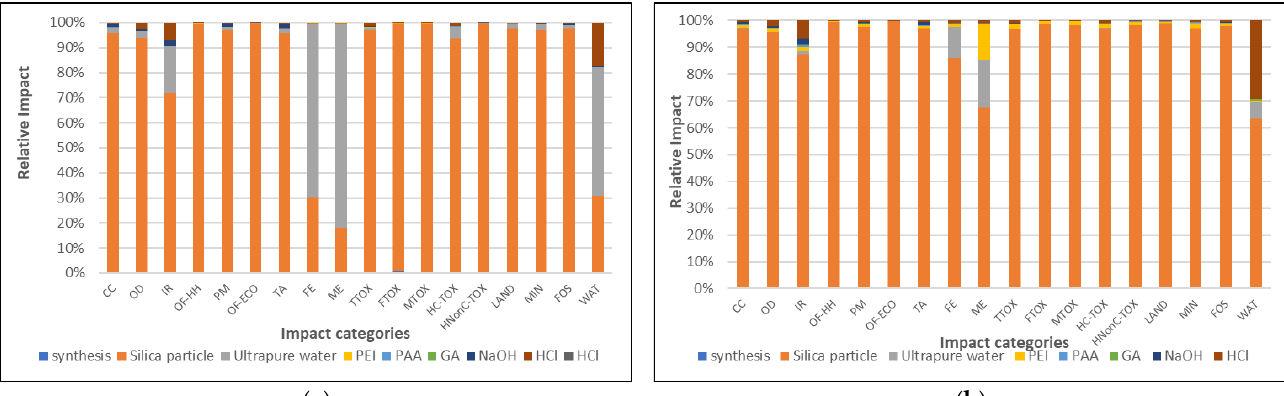
Figure 2. Environmental profile structures of the composite materials ( a ) . LbL- IS//(PEI/PAA) 4 . 5 (r = 0.1); ( b ) One-pot IS//(PEI/PAA)c (r = 0.1).